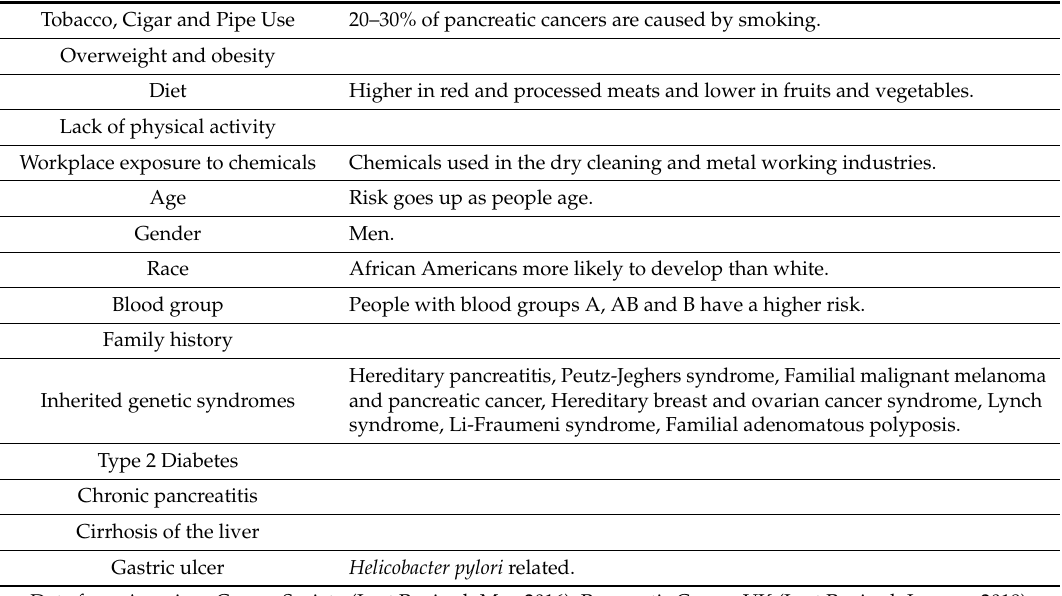
Table 1. Pancreatic cancer risk